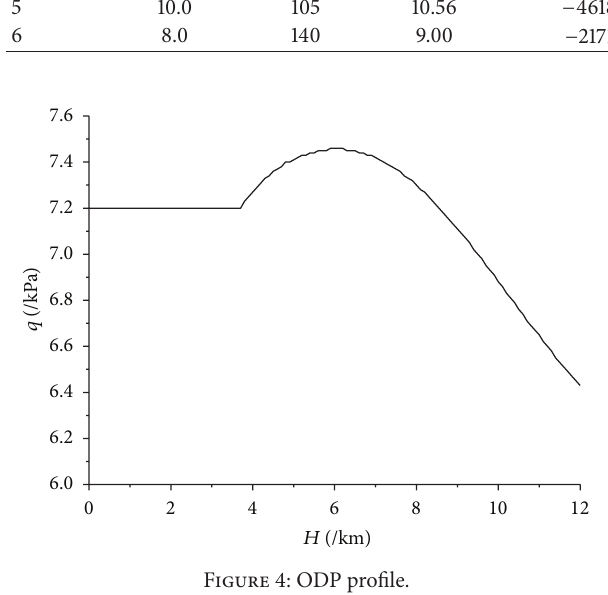
Figure 4: ODP profile.